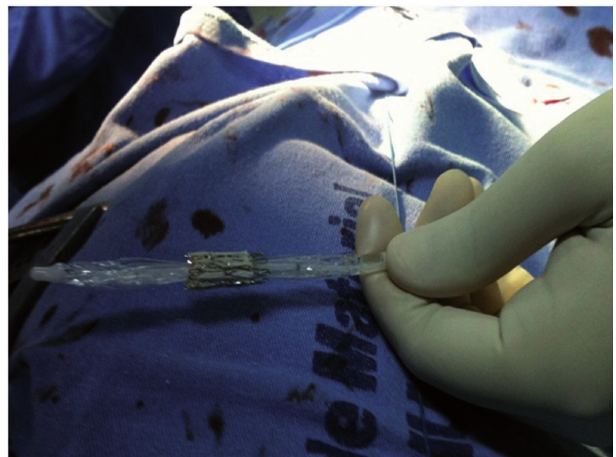
Fig. 3 – Transcatheter aortic valve mounted and crimped onto